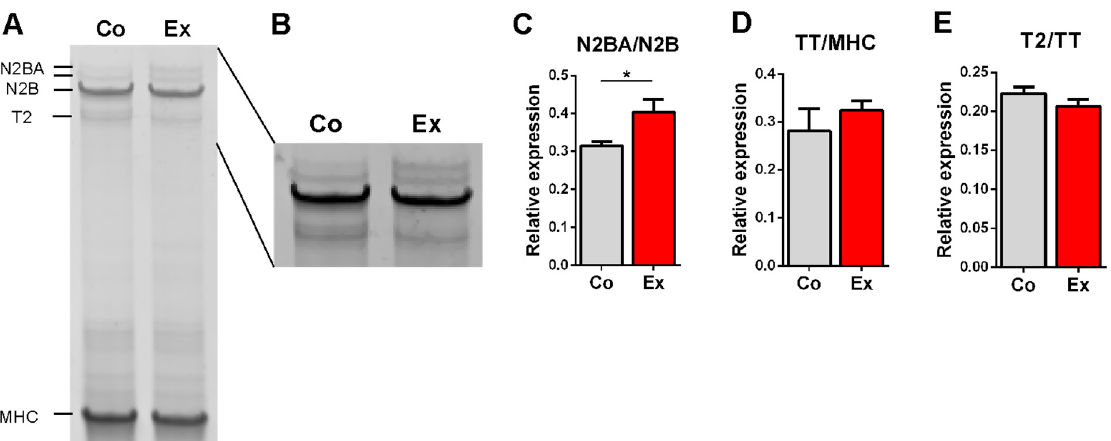
Figure 1. Titin isoform analysis. ( A ) Example gel electrophoresis of a control and exercised LV sample. ( B ) Linear contrast adjustment also applied to the original image for better visualization. ( C ) The ratio of the more compliant N2BA and the stiffer N2B titin isoform is increased in exercised rats. ( D ) Total titin (TT) to Myosin Heavy Chain (MHC) ratio and ( E ) the titin degradation product T2 relative to TT did not differ between the two groups. n = 6/group, * p < 0.05.